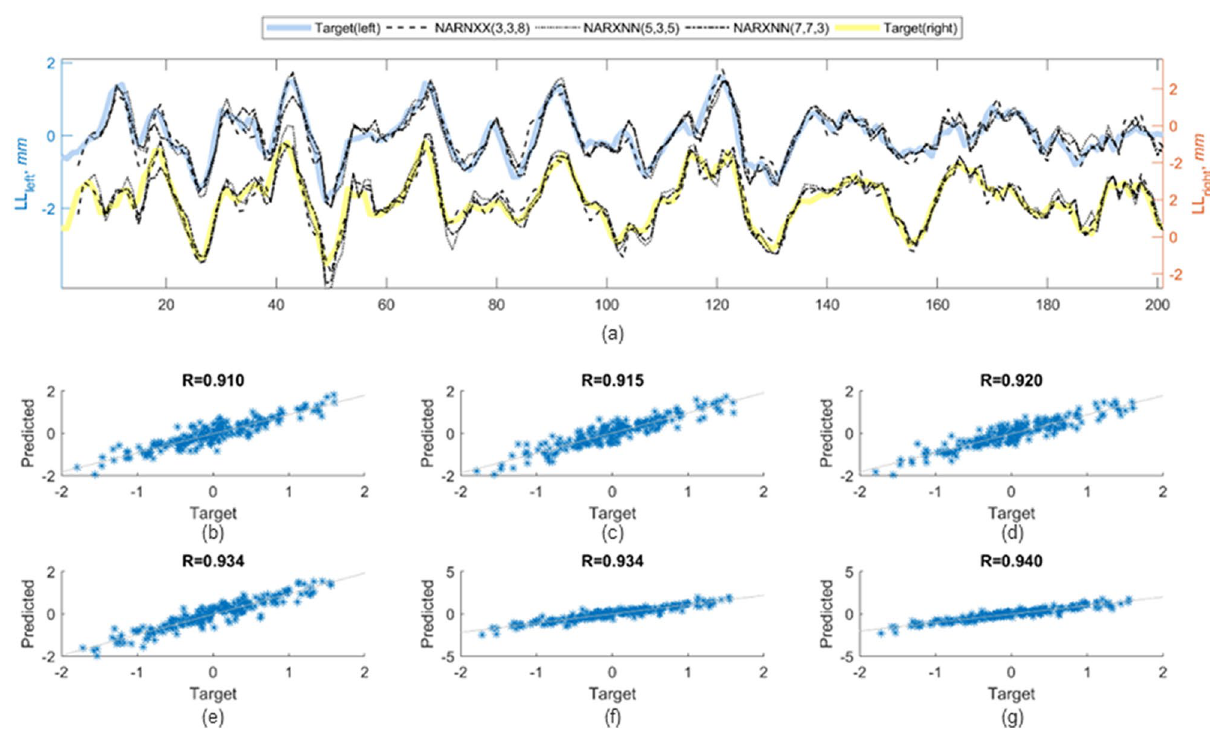
Figure 7. Predicted and target values of longitudinal track level of S2 for left and right rail are superimposed in the plot ( a ). Overall prediction accuracy of different networks can be observed from the scatter plot ( b – d ) and ( e – g ) for left and right rail,